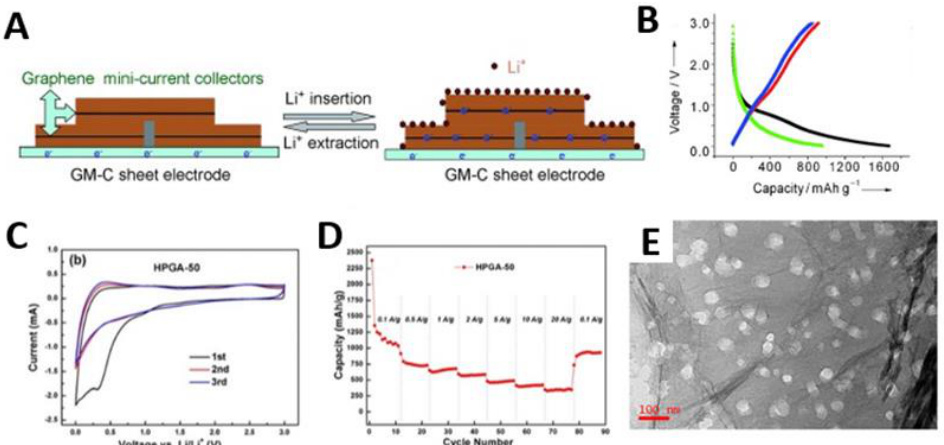
Figure 10. ( A ) Lithium insertion and extraction in mC/G sheets, where G acts as mini-current collectors during discharge and charge processes. ( B ) First two discharge-charge curves (first discharge (black), first charge (red), second discharge (green), second charge (blue)). ( A , B ) Reprinted with permission from Ref. [55], Copyright (2010) John Wiley and Sons. ( C ) First three cyclic voltammograms of hierarchical porous graphene aerogels (HPGA) anode at a scan rate of 1 mV s −1 between 0.1 – 3.0 V. ( D ) Rate capability of the HPGA-50 anode. ( E ) TEM image of HPGA-50. ( C – E ) Licensed under CC-BY from Ref. [107].